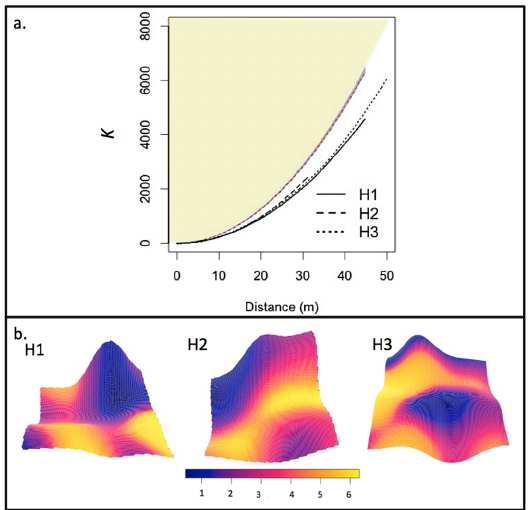
Figure 4. ( a ) Bivariate K ‐ functions of associations between residual trees and post ‐ fire conifer regeneration in the Hayman Fire plots (H1, H2, and H3). Attraction (yellow shaded region) is indicated by an observed K (r) that is above the CSR simulated confidence envelope (grey shaded region), while repulsion is indicated by an observed K (r) that falls below the envelope. Trees and post ‐ fire conifer regeneration showed repulsion at distances greater than 1 m; ( b ) Perspective plots of residual tree and post ‐ fire conifer regeneration density (trees m − 2 ). The height of the plot represents residual tree density and the color indicates regeneration density. Regeneration densities were higher in areas with lower tree densities.